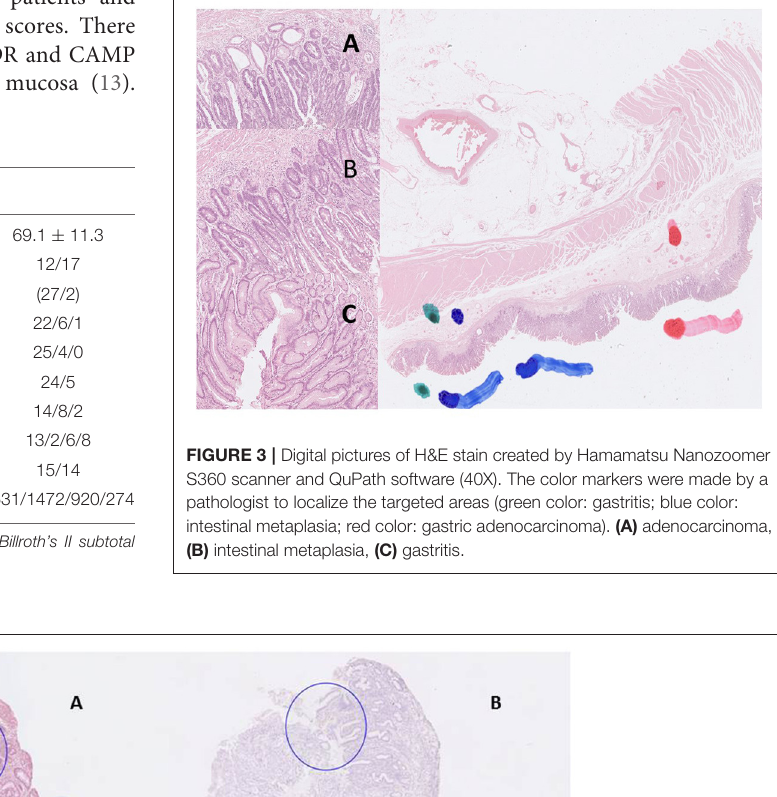
Frontiers in Medicine |